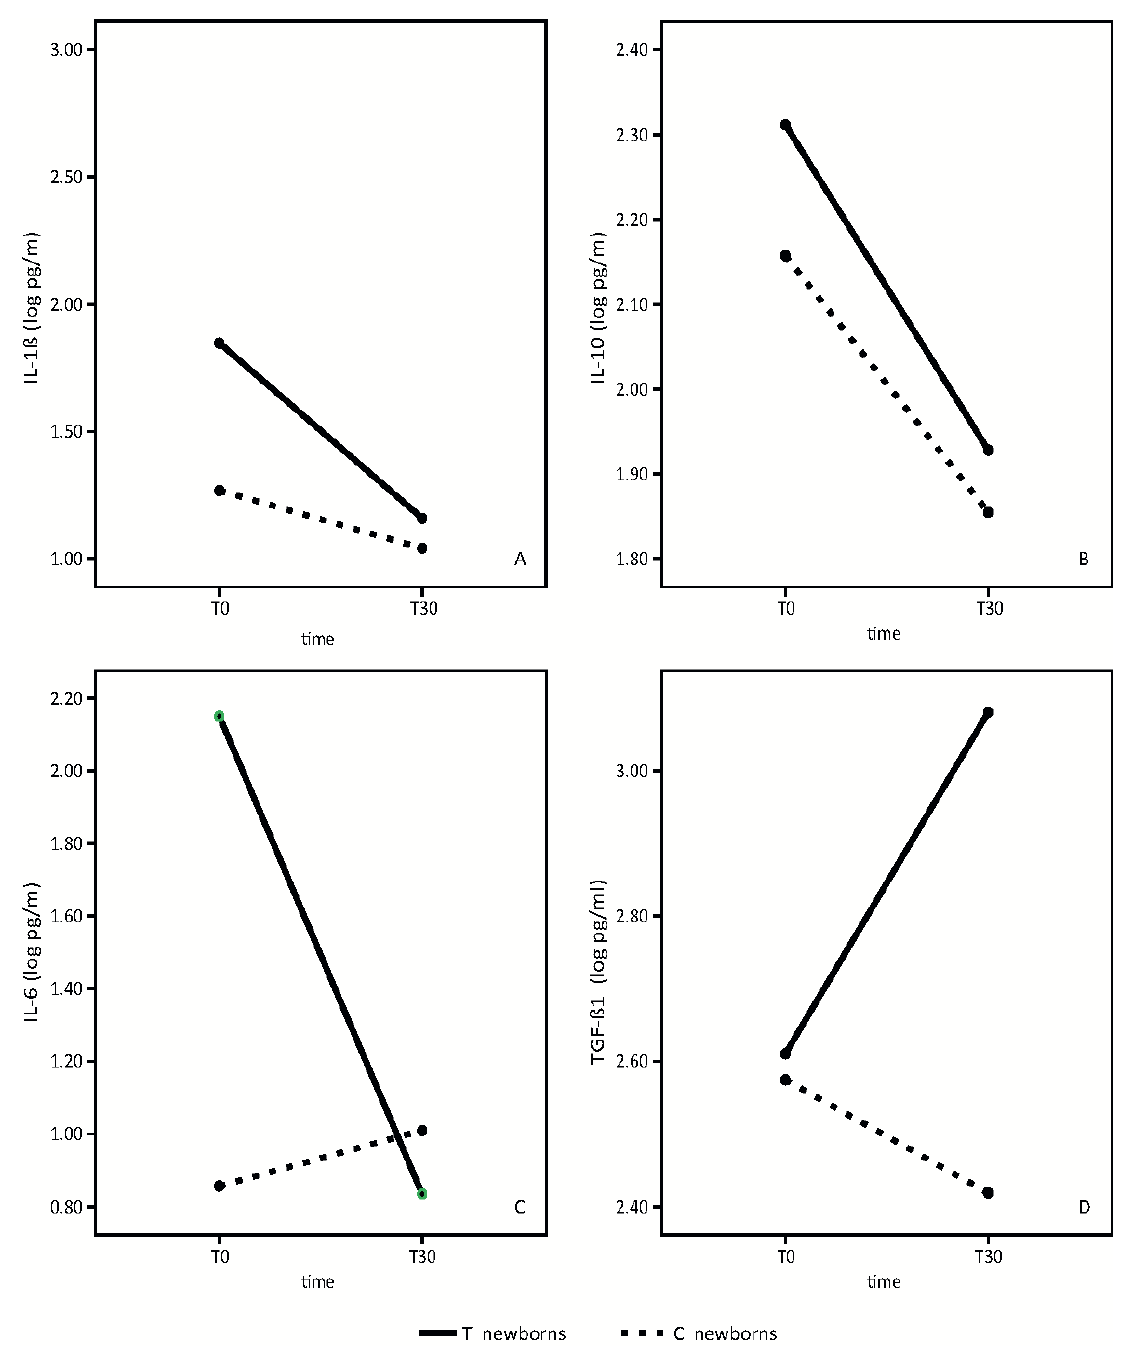
Figure 2. Breast milk cytokine patterns in treatment (T) and control (C) newborns at observational times T0 and T30. ( A ) (Interleukin ‐ 1 β mean values); ( B ) (Inteleukin ‐ 10 mean values); ( C ) (Interleukin ‐ 6 mean values); ( D ) (Transforming Growth Factor mean values).